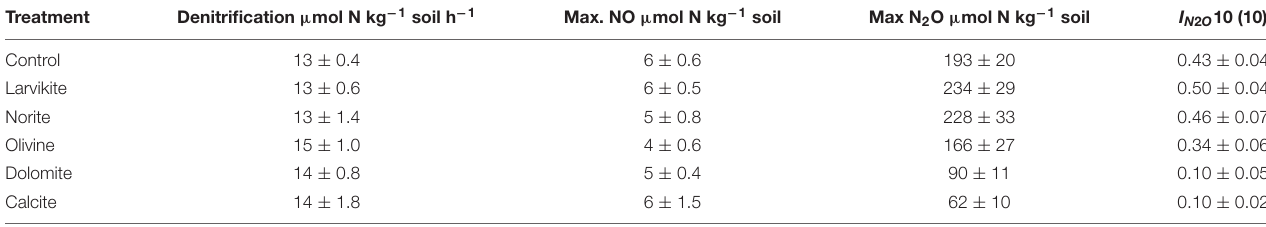
TABLE 4 | Denitrification rate and production of NO and N 2 O during anoxic incubation of remolded soils amended with nitrate. Treatment